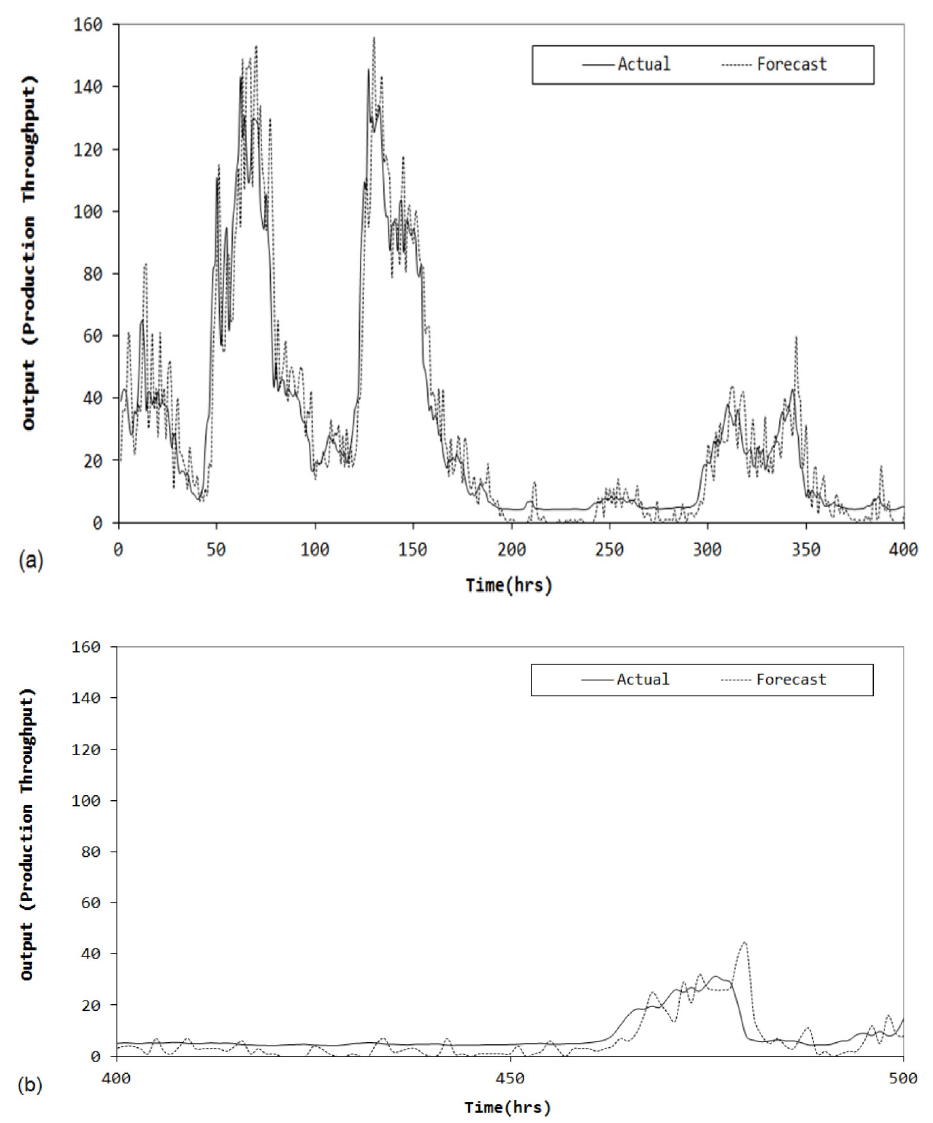
Figure 9. Production throughput forecasting using a IHO-GRNN: (a) training data set, (b) testing data set